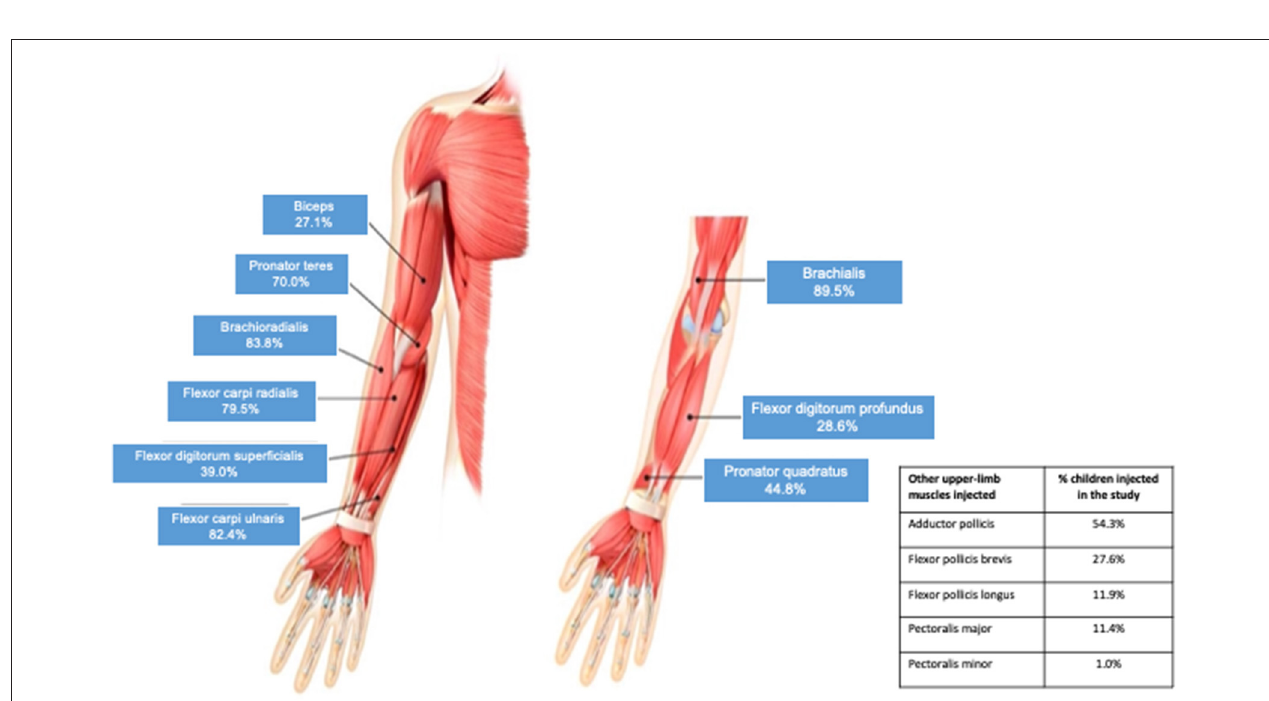
FIGURE 2 | Muscles most commonly injected for pediatric upper limb spasticity (all cycles).